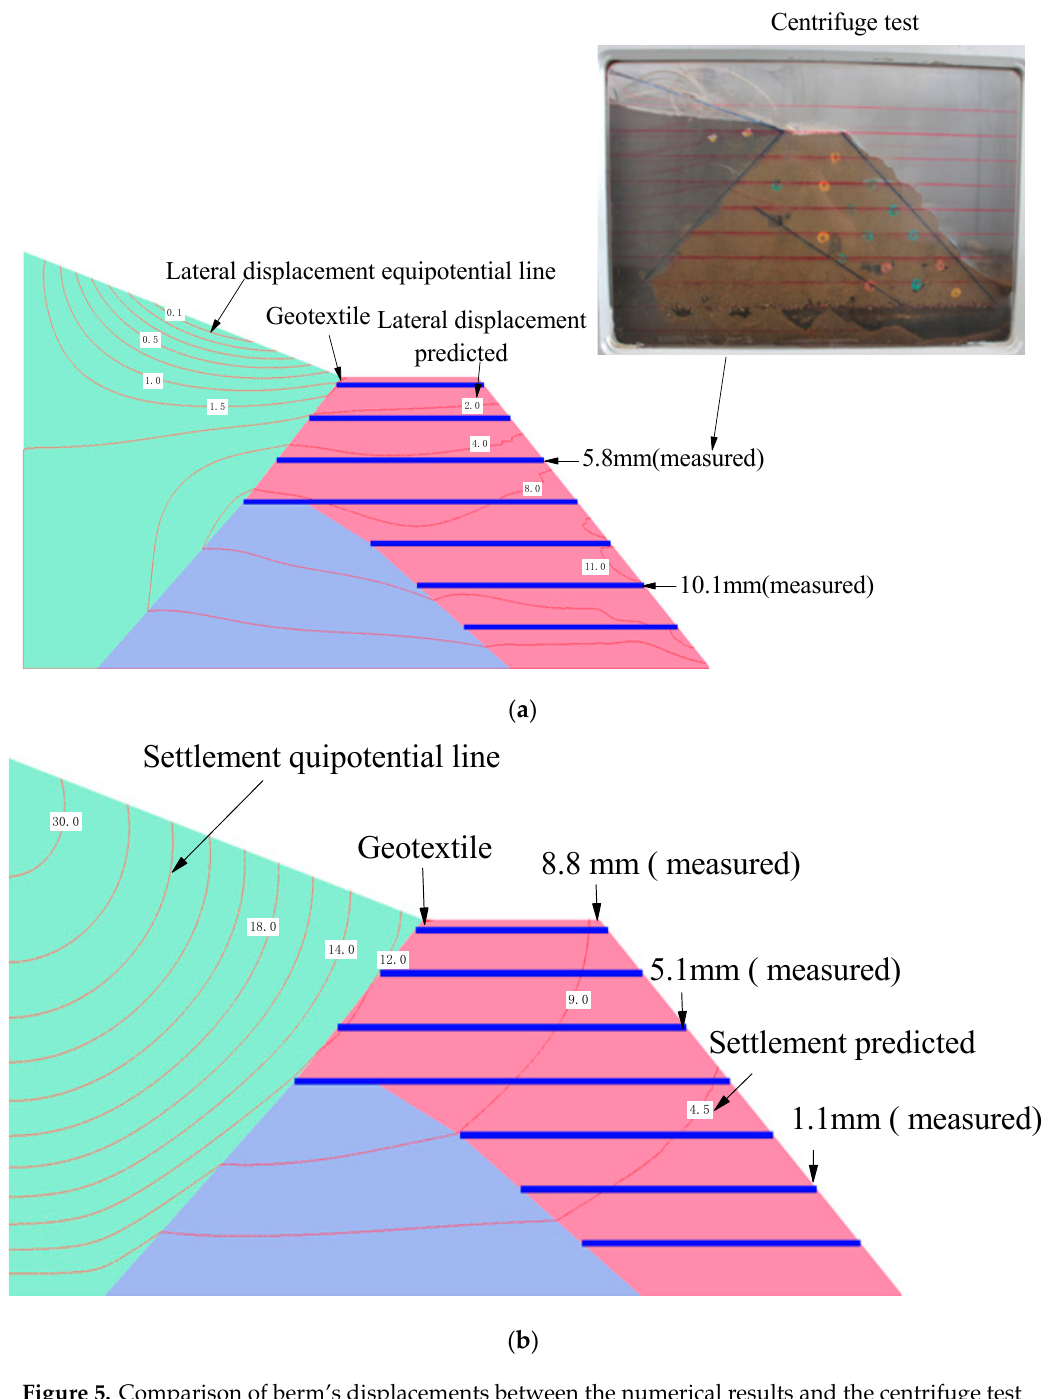
Figure 5. Comparison of berm’s displacements between the numerical results and the centrifuge test data: ( a ) Lateral displacement (mm) and ( b ) settlement (mm).